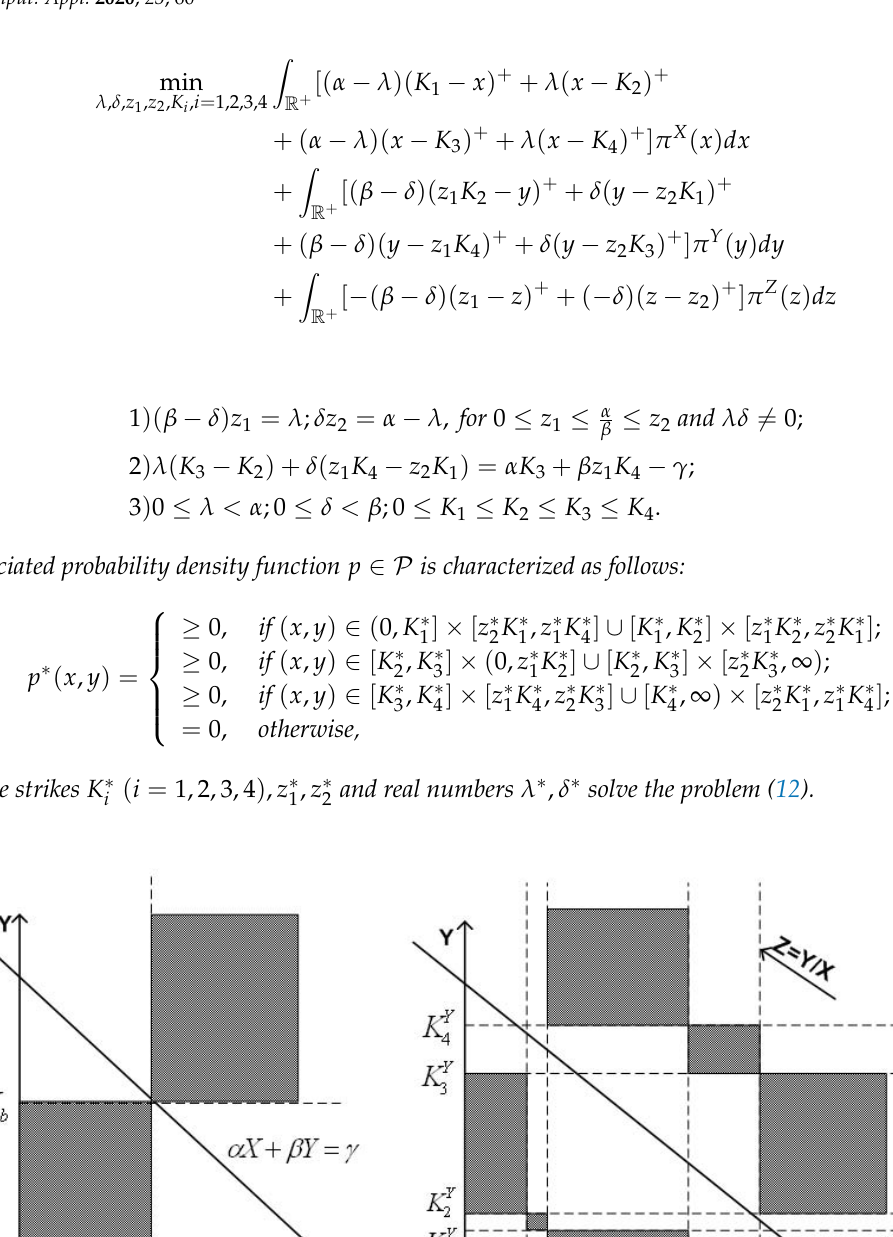
X ) = ( z ) for 0 < z < z , K Y , K Y , K Y , z 2 K X , z 1 K X , z 2 K X 2 . 1 K 1 2 3 2 3 1 4 1 4